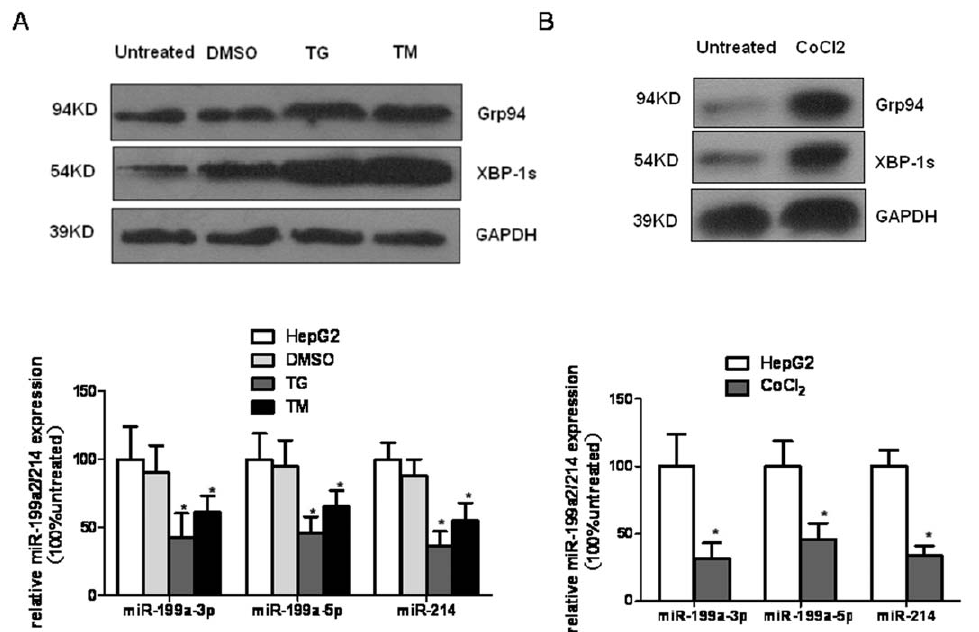
Figure 5. ER stress induces miR-199a/214 downregulation in HCC cells. ( A ) HepG2 cells treated with Thapsigargin(TG, 5 m mol/L) and tunicamycin (TM, 5 m g/ml) for 24 h were analyzed by western blotting for GRP94 and XBP1 expression levels and analyzed by real-time RT-PCR for miR-199a-3p/-5p and miR-214 expression. ( B ) HepG2 cells treated with CoCl 2 (100 m M) for 24 h were analyzed by Western blotting for GRP94 and XBP1 expression levels and analyzed by real-time RT-PCR for miR-199a-3p/-5p and miR-214 expression. Columns, mean of three independent experiments; bars, SD; *P , 0.05 vs untreated (HepG2) or DMSO-treated.